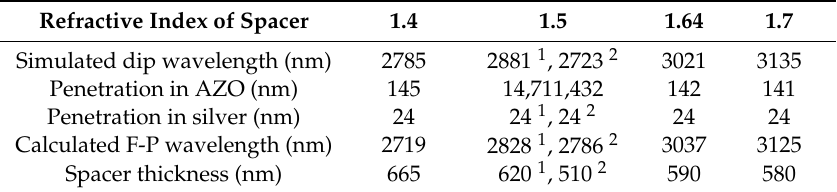
Figure 3. Simulations of the reflection spectrum of patterned AZO thin film separated from a thin film of silver by a spacer with an index of refraction n = 1.4 (purple), 1.5 (blue), 1.64 (red) and 1.7 (black). Total light absorption occurs at wavelength λ when the thickness of the spacer material meets the F-P condition for different indexes of refraction. Table 1. Optical properties of multi-layer structures, SPP wavelength and F-P wavelength.